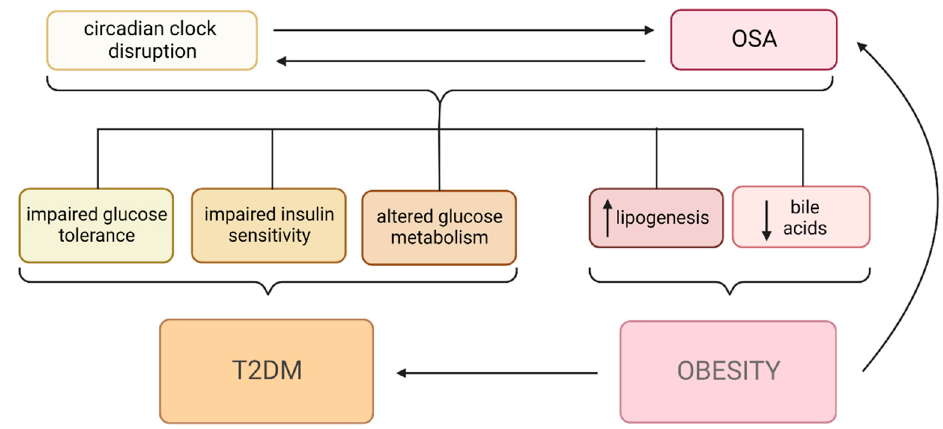
Figure 4. Summary of relationships between obstructive sleep apnea (OSA), circadian clock dis- ruption, and its clinical effects. The relationship between circadian clock disruption and OSA is bidirectional. They both lead to variable metabolic changes—impaired glucose tolerance, impaired insulin sensitivity, and altered glucose metabolism—which result in the development of diabetes mellitus type 2 (T2DM). Increased lipogenesis and decreased bile acid levels promote the development of obesity. Obesity is also an independent risk factor for both OSA and T2DM. OSA—obstructive sleep apnea, T2DM—diabetes mellitus type 2.